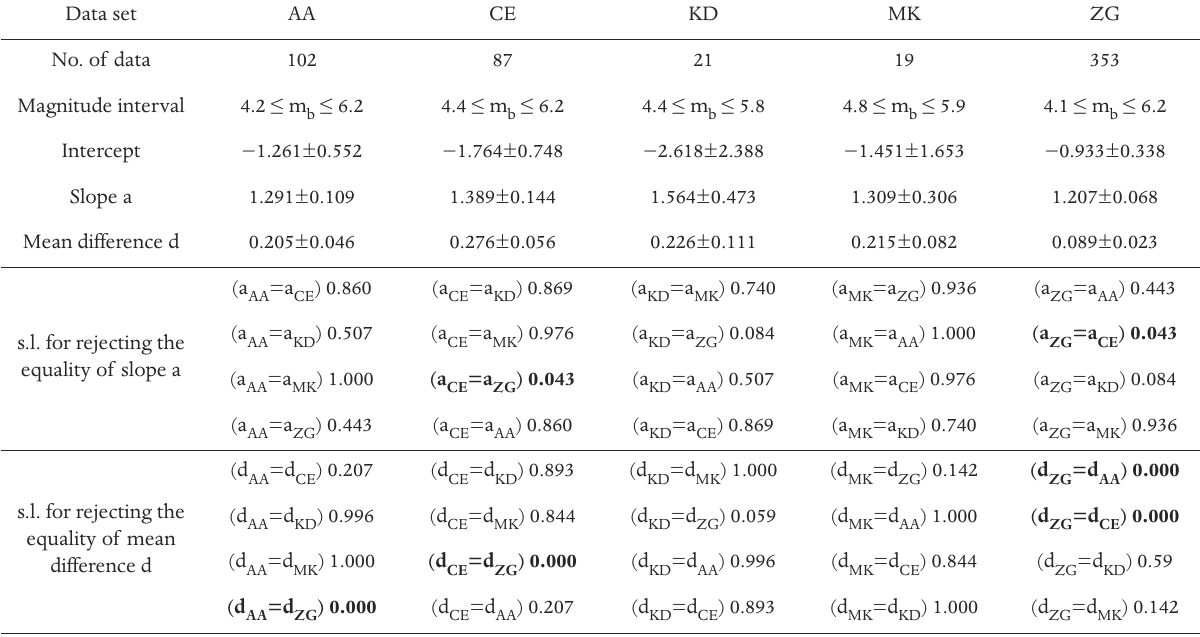
Table 1. GOR coefficients and Mean differences for the m –M data sets. Significance levels (s.l.) indicate the probabilities of rejecting the b w corresponding H hypotheses (within parentheses) when they are true (in boldface when <0.05). Values after ± indicate 95% confidence in- 0 terval. AA: Alborz–Azarbayejan, CE: Central–East Iran, KD: Kopeh Dagh, MK: Makran and ZG: